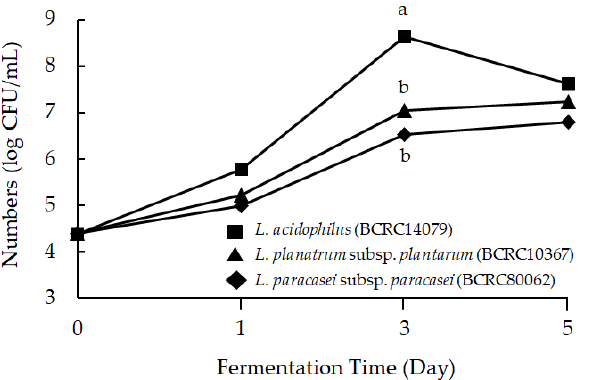
Data are shown as means ± SD ( n = 3). Significant differences are shown by various letters ( p < 0.05).